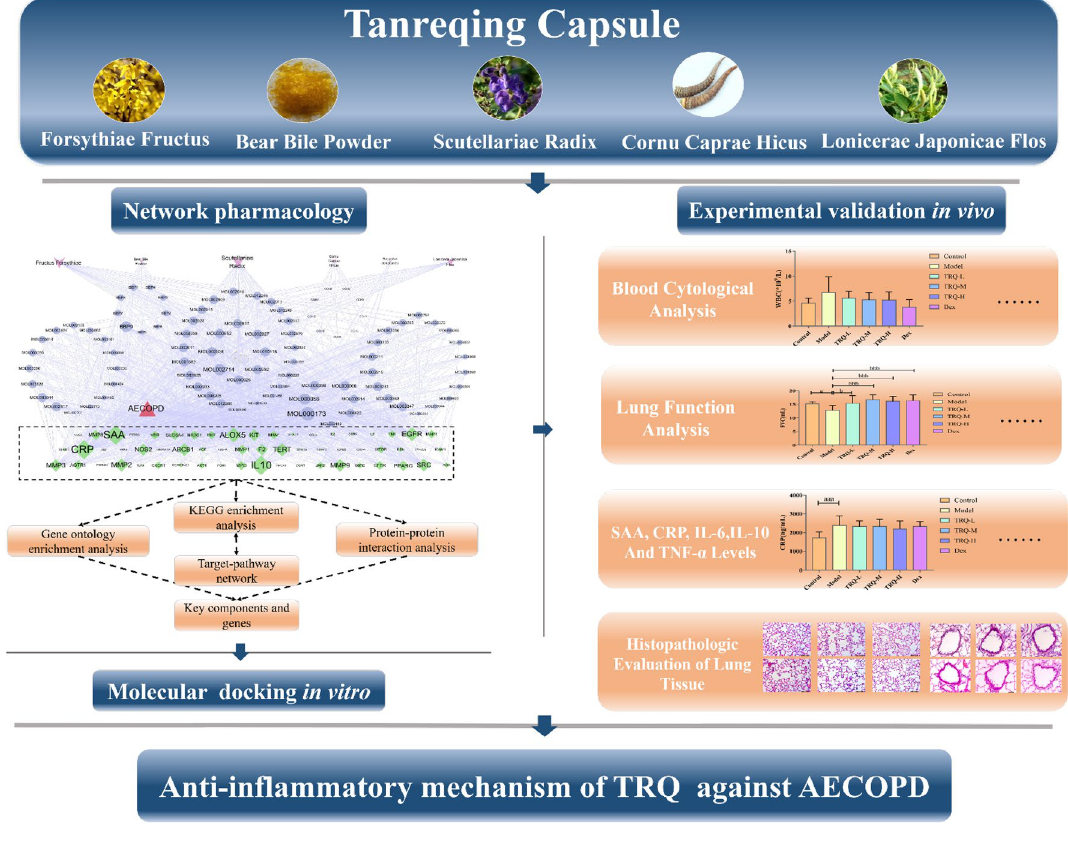
Figure 1. The workflow of the network pharmacology combined with the Pharmacodynamics